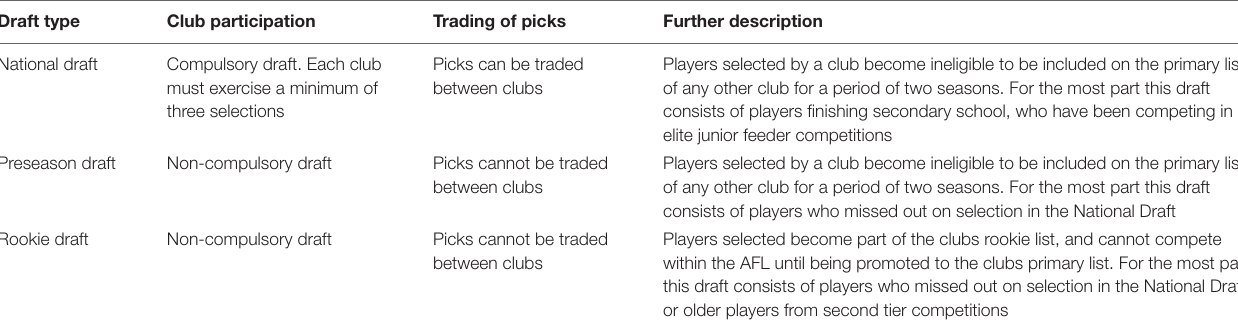
TABLE A2 | Descriptions of the three annual draft methods to enter an AFL